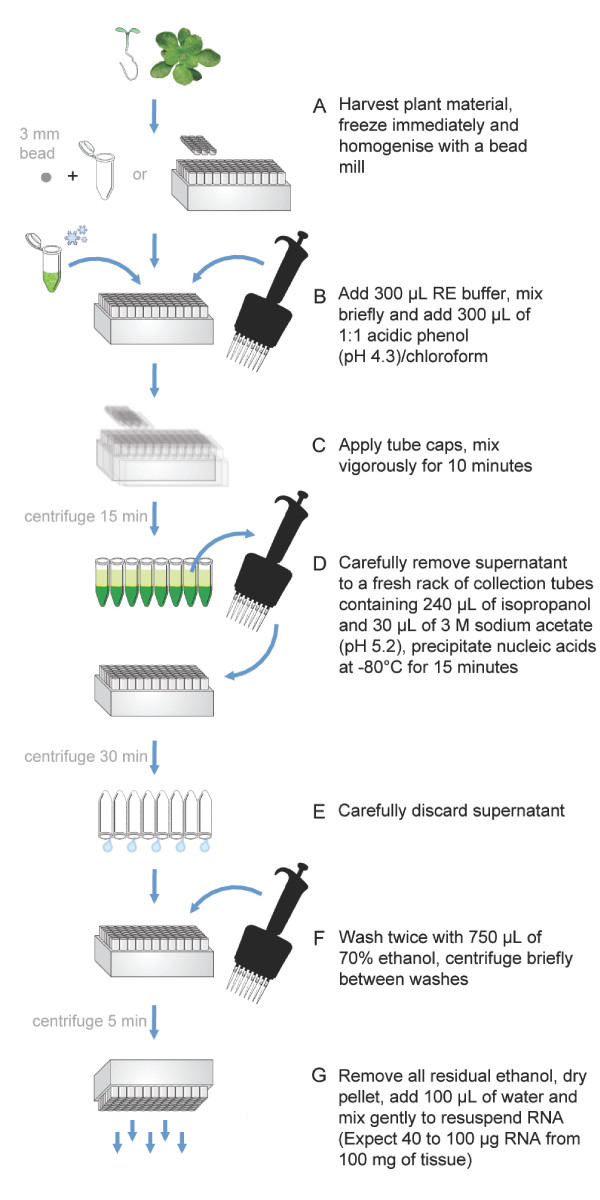
Summary bench protocol for HTP96 RNA extraction. High yields of good quality RNA are isolated from as little as 100 mg of fresh tissue using a streamlined P:C-L RNA extraction method in 96-well plate format. A. Harvested tissue is frozen immediately with liquid nitrogen and homogenised using a commercial bead mill. B. Add 300 μL RE buffer, apply collection tube caps and mix briefly. C. Briefly centrifuge to collect contents, add 300 μL of P:C (pH 4.3). Apply fresh collection tube caps and mix thoroughly. D. Nucleic acids in the supernatant are precipitated with 240 μL of isopropanol and 30 μL of 3 M sodium acetate (pH 5.2) at -80°C. E. Tape the collection tubes to the rack and discard the supernatant by inverting the collection tube rack. F. Wash the nucleic acid pellet twice with 70% ethanol. G. Remove all traces of ethanol and allow the nucleic acid pellet to dry before resuspending in nuclease-free water.